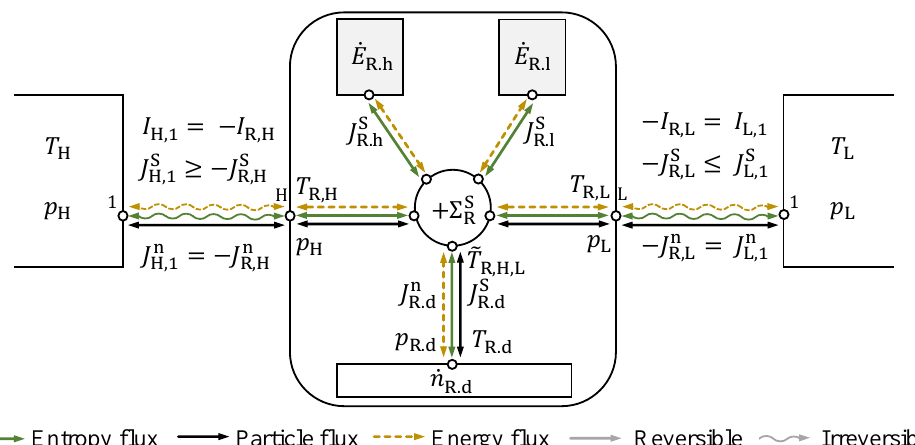
Figure 11. Schematics of the EEn -regenerator composed of an engine, two internal heat reservoirs, and an internal gas reservoir [49]. The sum of the two internal heat reservoir’s energies E R.h and E R.l represents the energy of the regenerator matrix, whereas their single values determine the contact point temperatures T R,H and T R,L via Equations (38) and (39). The internal gas reservoir represents the regenerator dead space with the contained number of gas particles n R.d . This gas reservoir is maintained at the logarithmic mean temperature ˜ T R,H,L of T R,H and T R,L . Thus, the working gas inside the regenerator dead space is attributed the proper effective temperature, which was not the case in the ES -regenerator and the EE